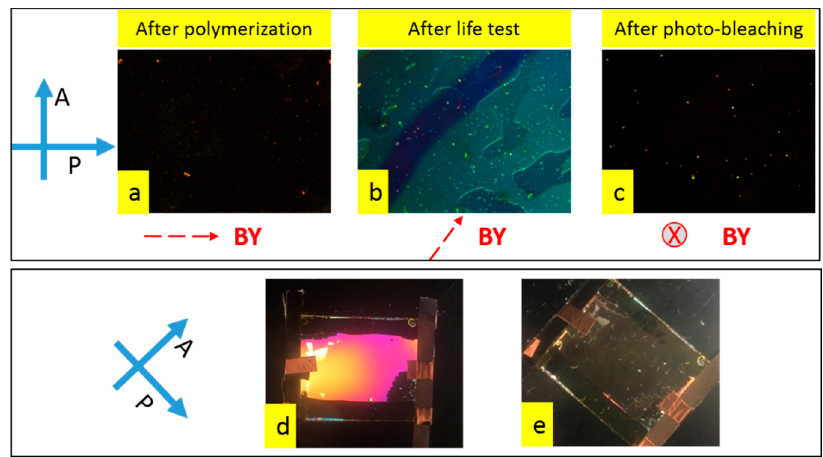
Figure 4. Polarized microscope images of the cell (0.5% cell in Figure 2): ( a ) before life-test; ( b ) after life test; and ( c ) after photo-bleaching. The BY alignment was represented by a red dash arrow with a dynamic re-orientation direction after the life-test and photo-bleaching with respect to the polarizer and/or analyzer direction. Macroscopic observation of cells after photo-bleaching when the original LC alignment was 45° to polarizer ( d ) or parallel to one polarizer ( e ).